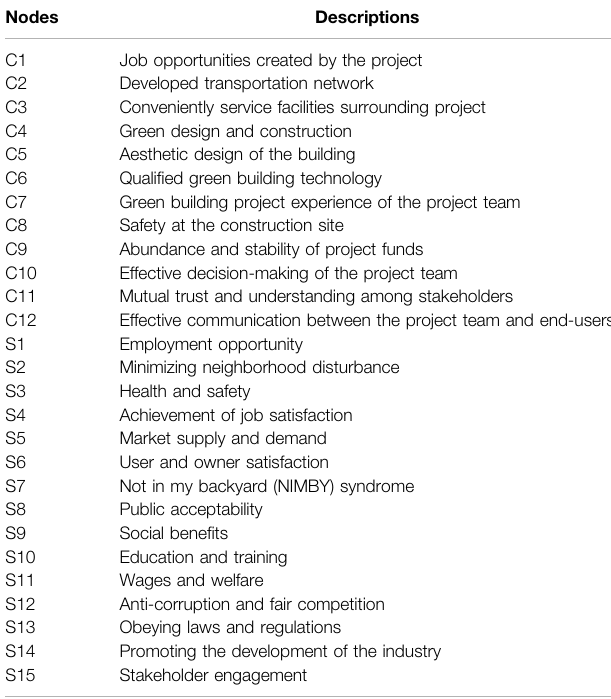
TABLE 3 | The demographic information of respondents. TABLE 4 | Bayesian network (BN) node numbers and